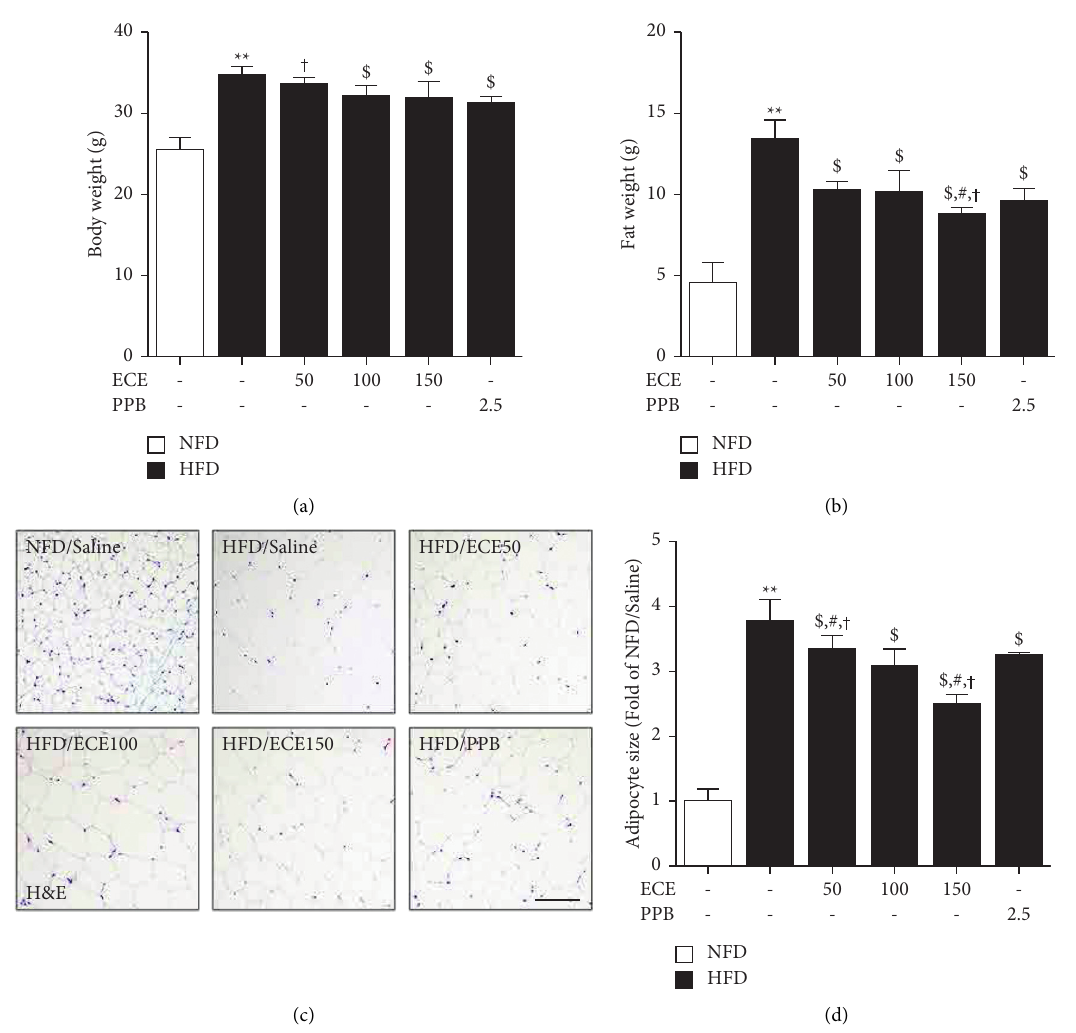
Figure 1: ECE and PPB decreased body weight, fat weight, and visceral adipocyte size in HFD animals. C57BL/6N male mice were fed a regular NFD or HFD for 4 weeks, and then NFD or HFD were also treated for the next 4 weeks with various substances. (a) Body weight; (b) fat weight increased in HFD mice, but ECE and PPB reduced; ((c), (d)) H&E stained visceral adipocyte size also decreased in ECE and PPB administrative mice and measured by using the Image J software. Scale bar � 100 μ m. All data are shown as mean ± S.D. ∗∗ , p < 0 . 01, vs. NFD/saline; $ p < 0 . 05, vs. HFD/saline; # p < 0 . 05, vs. HFD/ECE100; † p < 0 . 01, vs. HFD/PPB (Mann–Whitney U test). ECE, Ecklonia cava extract; H&E, hematoxylin & eosin, HFD, high-fat diet; NFD, normal fat diet; PPB, pyrogallol-phloroglucinol-6,